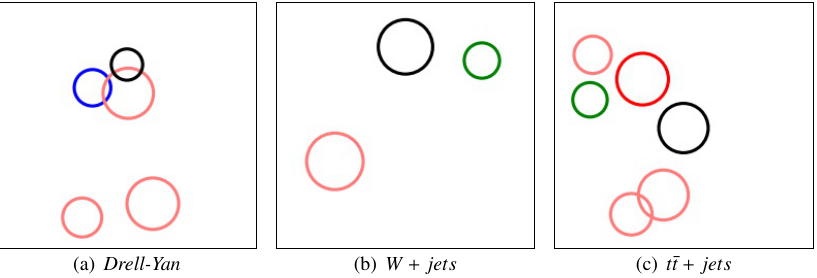
Figure 2. Examples of images corresponding to the three di ff erent classes of collisions being classified. The x-axis depicts the pseudorapidity η while the y-axis depicts the azimuthal angle ϕ .